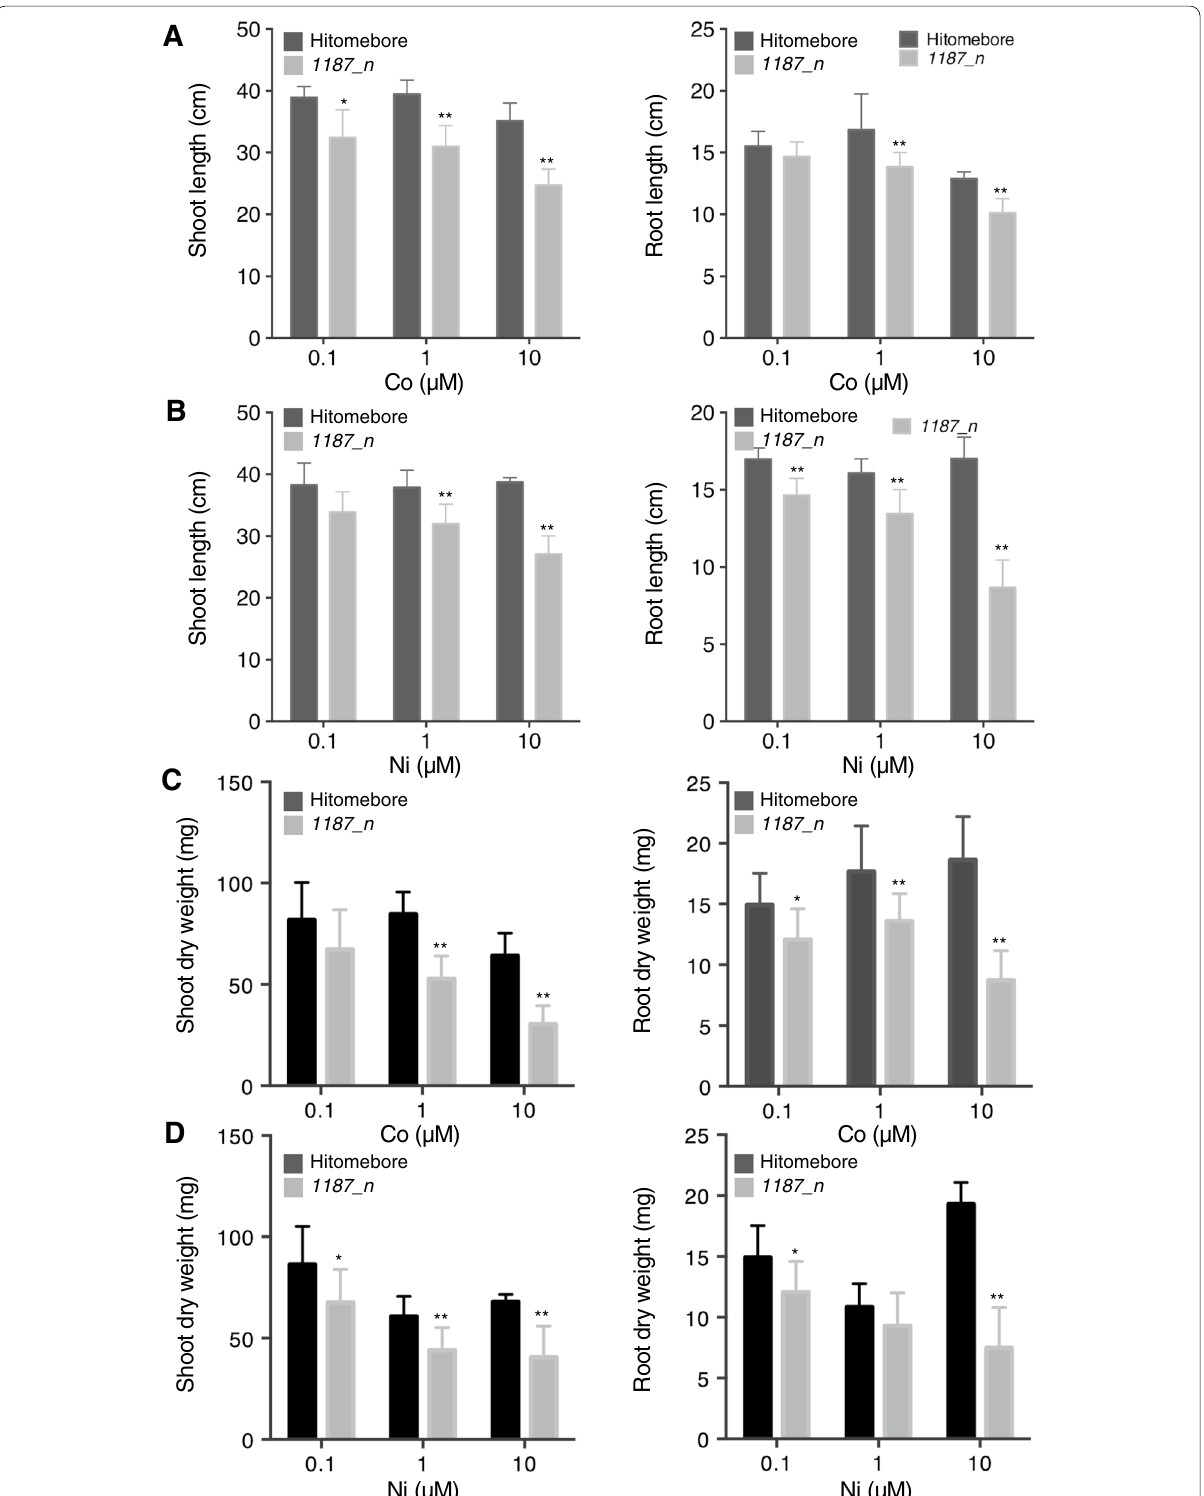
Fig. 2 Growth phenotype of Hitomebore and 1187_n under various Co and Ni conditions. Shoot (left panel) and root (right panel) lengths ( A , B ) and dry weight ( C , D ) under various Co ( A ) and Ni ( B ) conditions. Plants were grown in hydroponic culture for three weeks. Data represent the means SD (n 8–11). Student’s t -test, * p < 0.05; ** p < ± =